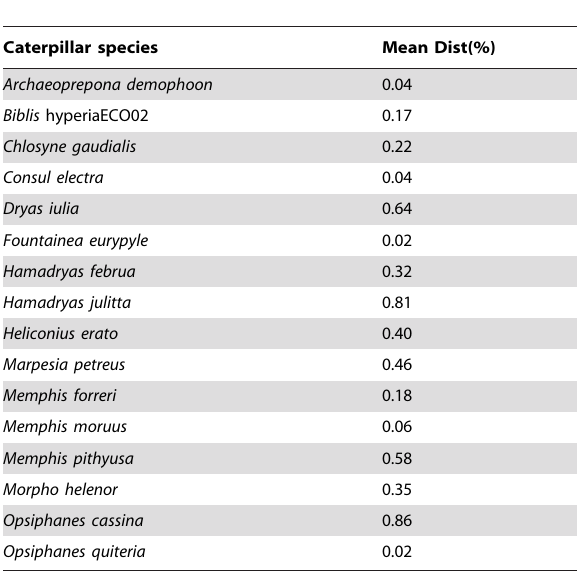
Table 3. Species assignments for caterpillars showing that the closest sequence match with adults of Nymphalidae was always much less than 2%